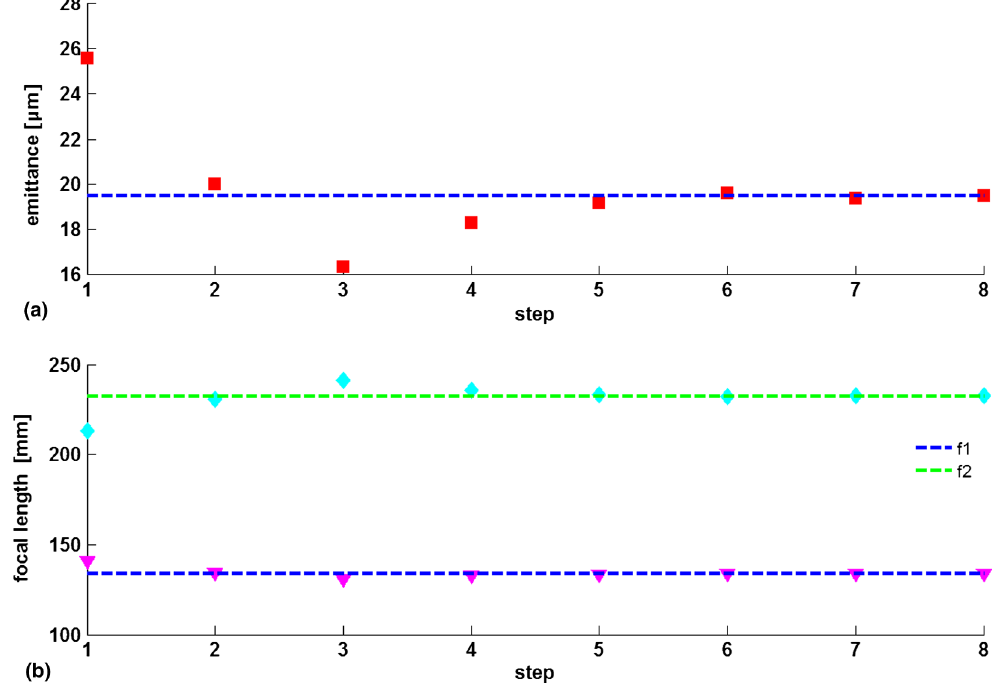
FIG. 2. Plots show convergence of emittance (a) and focal lengths f 1 and f 2 (b) for a low space-charge beam with K ¼ 8 : 82 (cid:3) 10 (cid:1) 5 . The dashed line in (a) indicates the actual emittance while squares indicate the calculated emittance at each